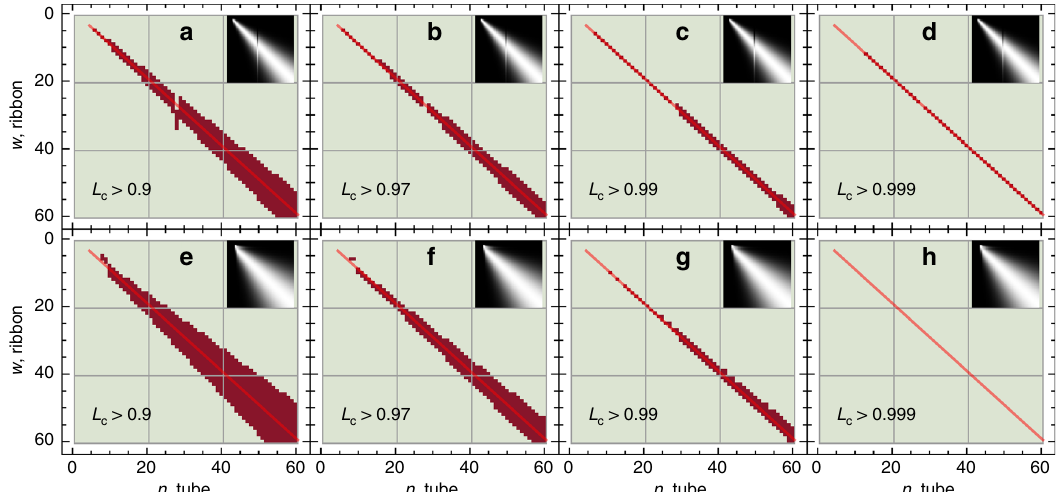
Fig. 3 Optical resonance alignment. AC maps for the optical absorption resonances of armchair SWCNTs and the bulk-bulk optical resonances of ZGNRs with a – d nearest-neighbor TBM t 1 ¼ 3 : 12 eV 55 and e – h fi tted TBMs from Table 1. The red line is the reference line n ¼ w þ 1. Insets of the graphs display the full AC maps before discrimination, where the color gradient from black to white corresponds to the increase of the AC values. The dark red regions > L signify L , where L is a chosen threshold for the alignment coef fi cient. The fi rst resonance is excluded from the armchair SWCNTs datasets in c c ; th c ; th all